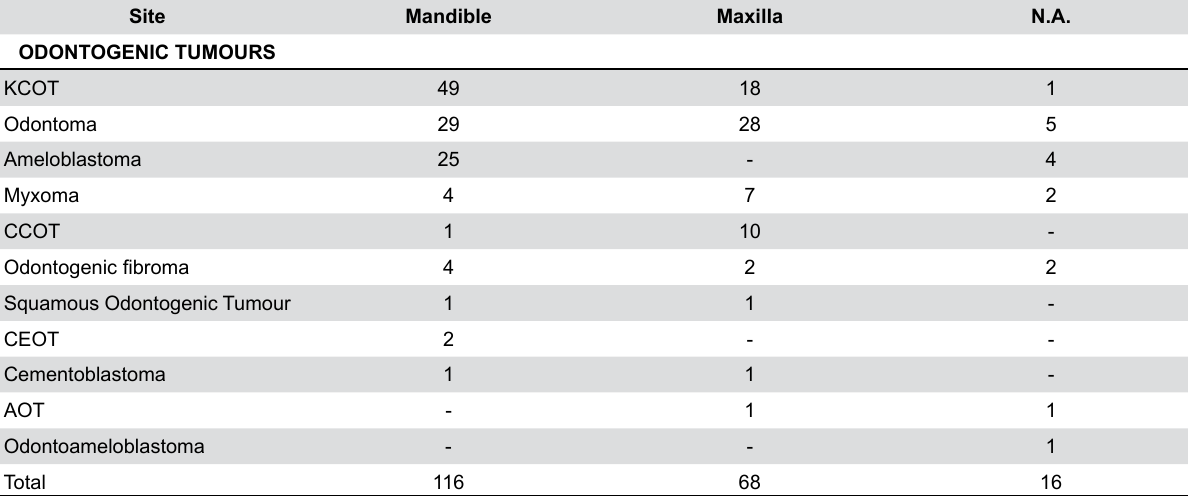
Table 3- Distribution of OTs according to anatomical site in a Brazilian Oral Pathology Center